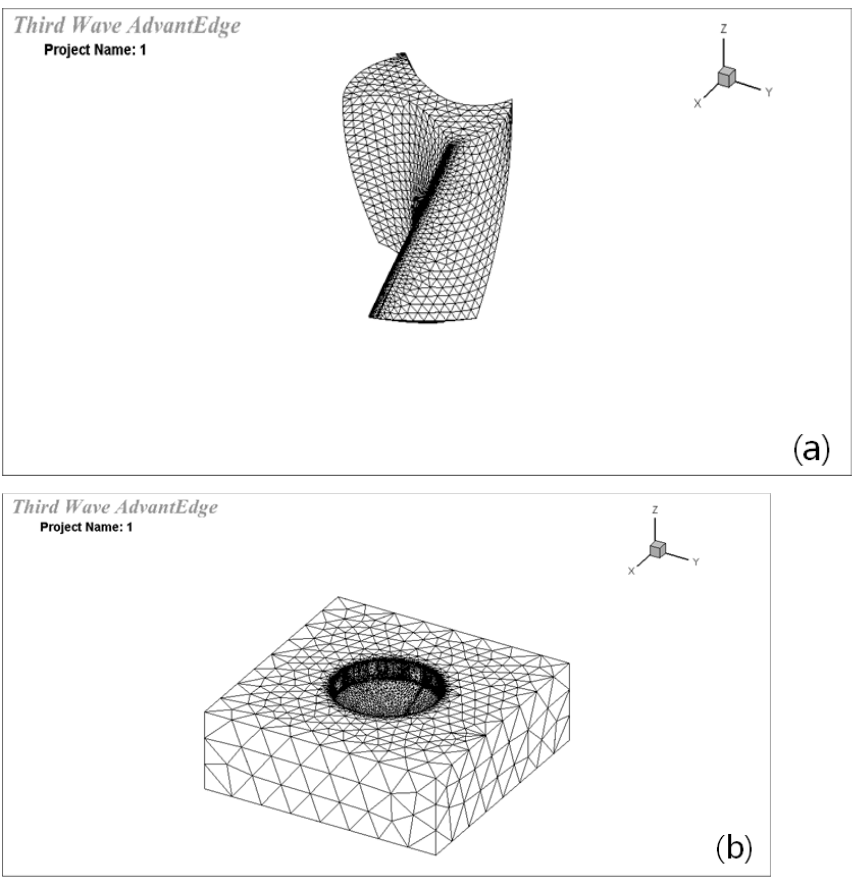
Figure 2. ( a , b ) The finite element model of the tool and material. Table 2. Parameters of the Johnson-Cook model